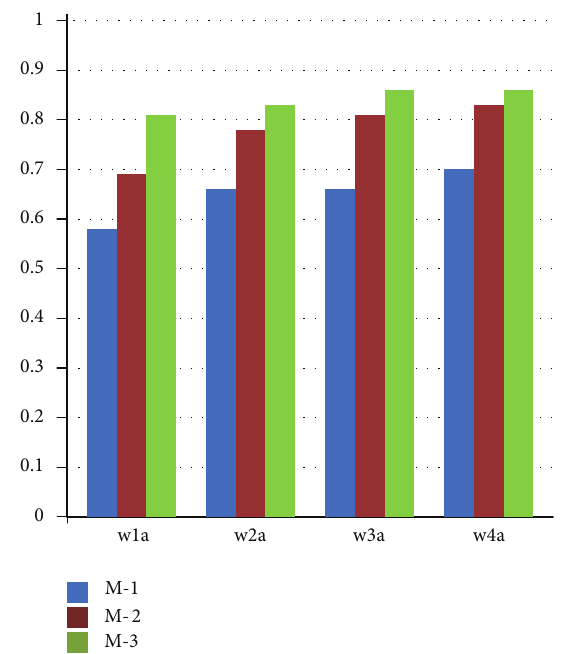
Figure 7: Comparison of the 𝐹 -measure among traditional C-SVM (M-1), number proportion-based optimization (M-2), and density- based optimization (M-3) via datasets in which the size of the negative instances was far greater than that of the positive